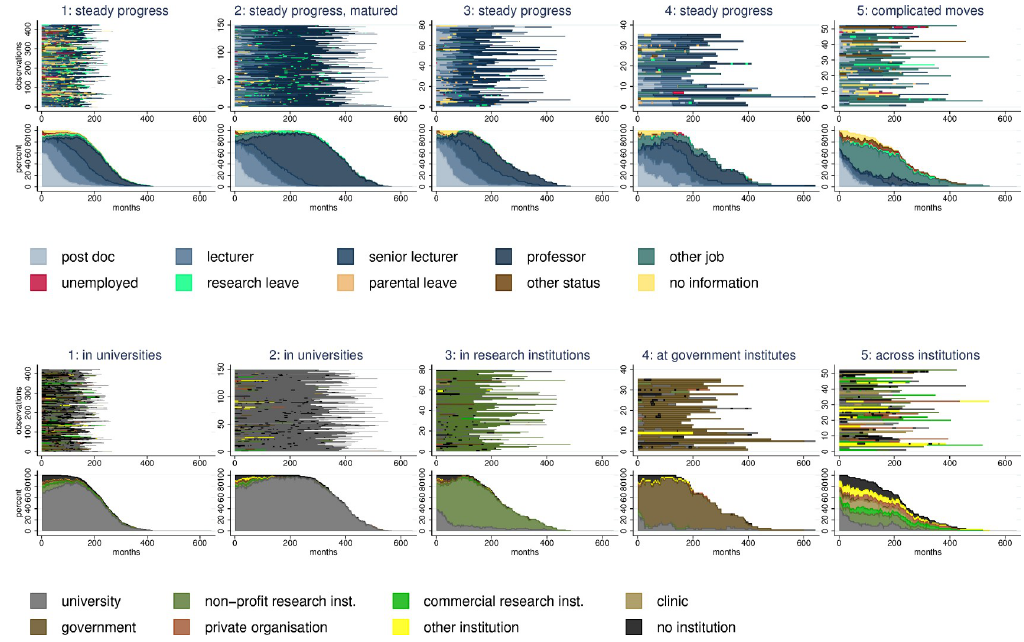
Fig 2. Advanced grant career patterns. Sequence index plots and status proportion plots for positions and